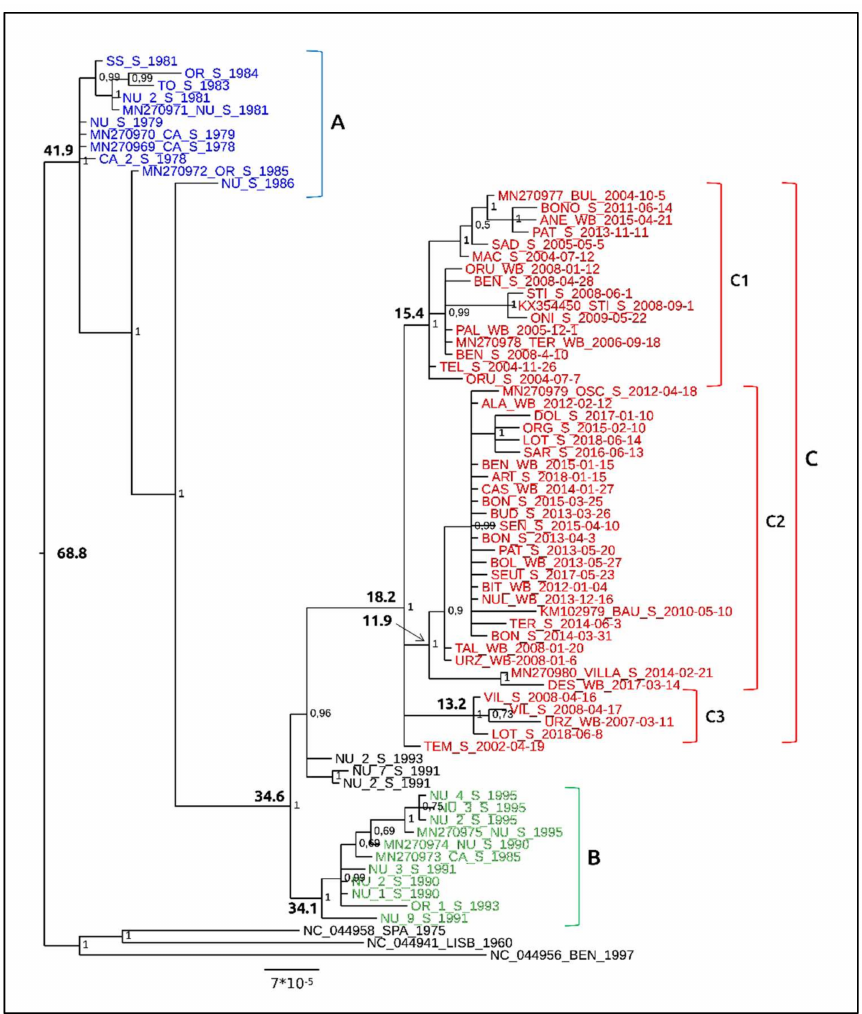
Figure 5. Bayesian phylogenetic tree based on the Sardinian ASFV genome dataset. Posterior probability values are reported for each node. The samples codes are as reported in Table